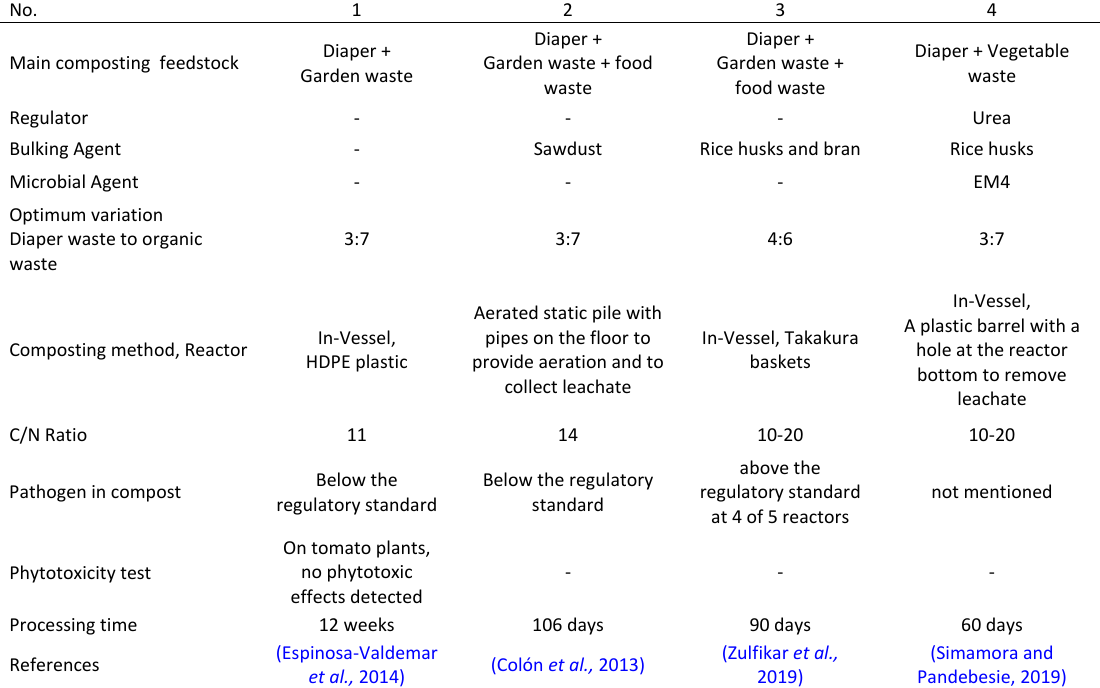
Table 3: Comparison of Disposable Diapers Composting Results Table 3: Com parison of Disposable Diapers Composting